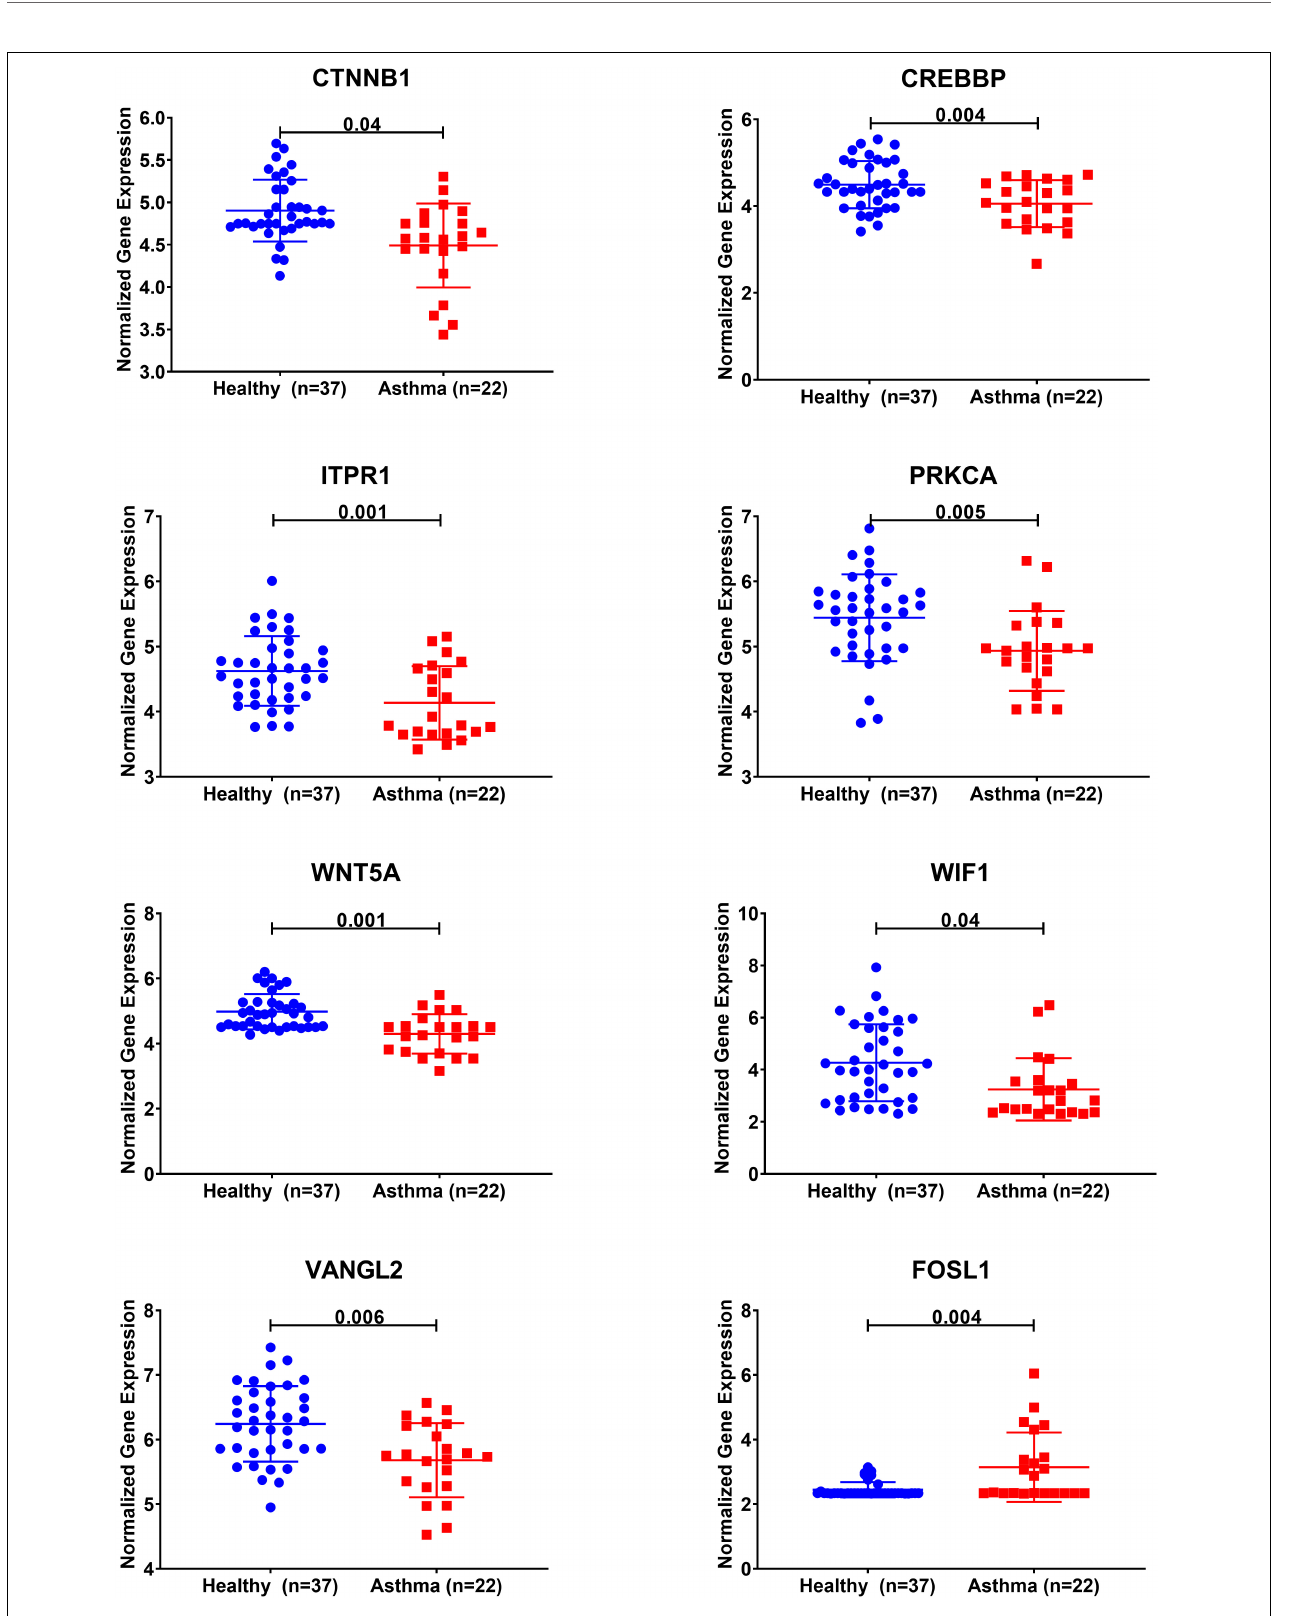
FIGURE 4 | Normalized gene expression of Wnt signaling pathway genes identified to be differentially expressed in severe asthmatic compared to healthy controls using bronchial epithelium transcriptomics data of the GSE64913 dataset.